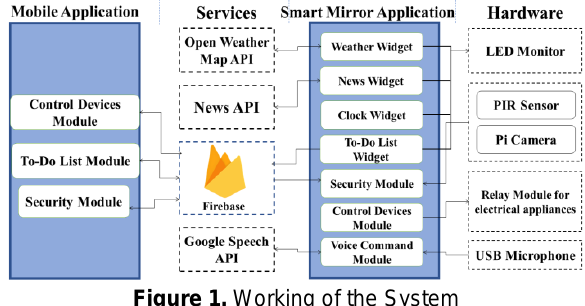
Figure 1. Working of the